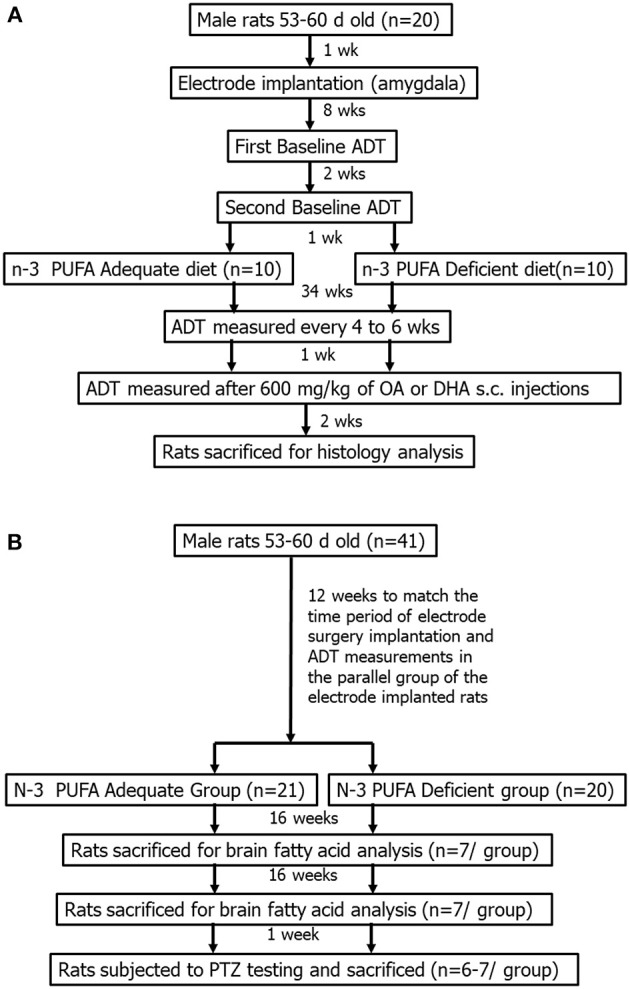
General experimental design for implanted (A) and non-implanted (B) rats. The amygdala-implanted rats (B) were randomized to an n-3 PUFA adequate or deficient diet for a total of 37 weeks. They were subjected to repeated ADT measurements, once every 4–6 weeks, for 34 weeks. ADTs were measured between weeks 35–37, following i.p., injection with 600 mg/kg of oleic acid (OA) or docosahexaenoic acid (DHA). The non-implanted rats (B) were randomized to the same diets for 33 weeks. Two-thirds of the animals were sacrificed following 16 and 32 weeks of dietary treatment, and one-third was subjected to pentylenetetrazol-induced seizures after 33 weeks of dietary treatment.